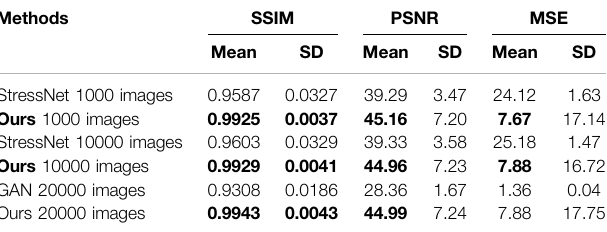
TABLE 3 | Quantitative results. Comparison with StressNet (Briñez de León et al., 2020b) and GAN (Briñez de León et al., 2020c) in the SSIM, PSNR, and MSE.